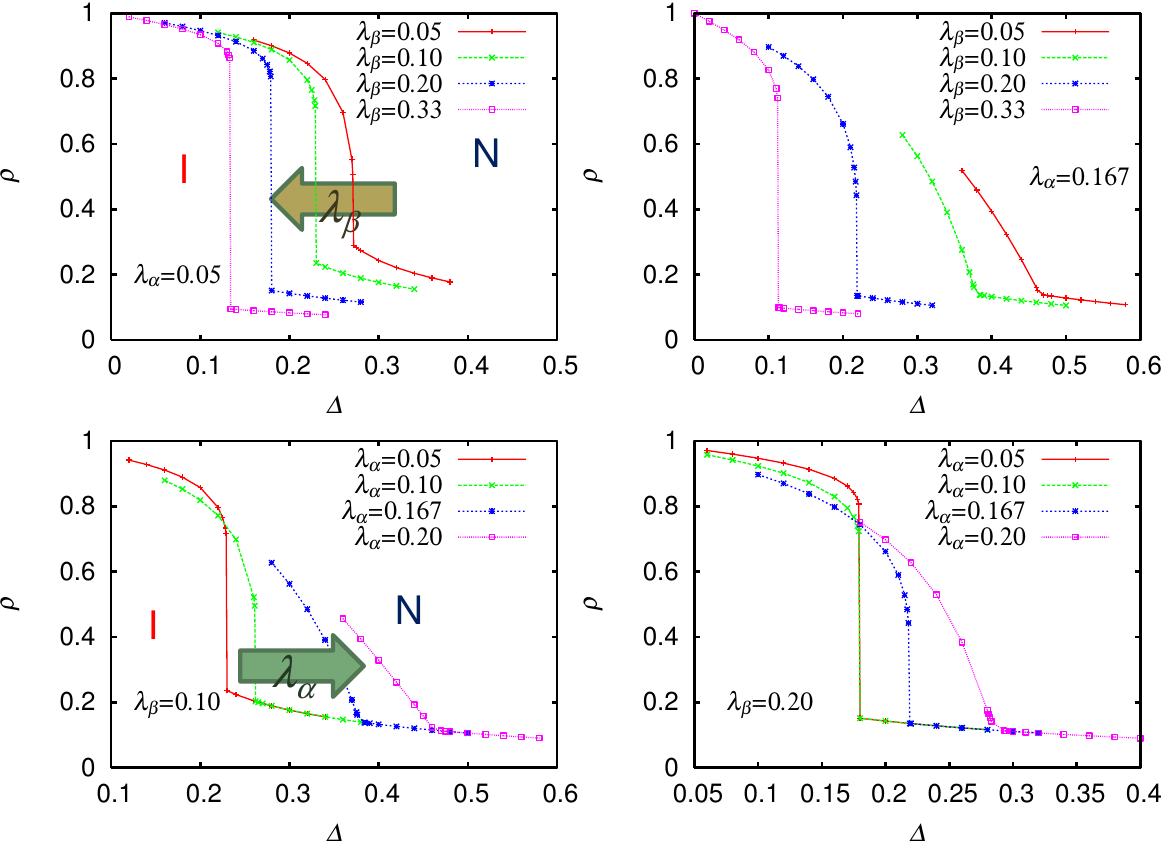
Figure 2. Ionicity ρ as a function of site energy difference ∆ for weak Peierls coupling λ = 0.05 (upper left), strong Peierls coupling λ α coupling λ = 0.10 (lower left), and strong Holstein coupling λ β From [28]. Reproduced with permission from